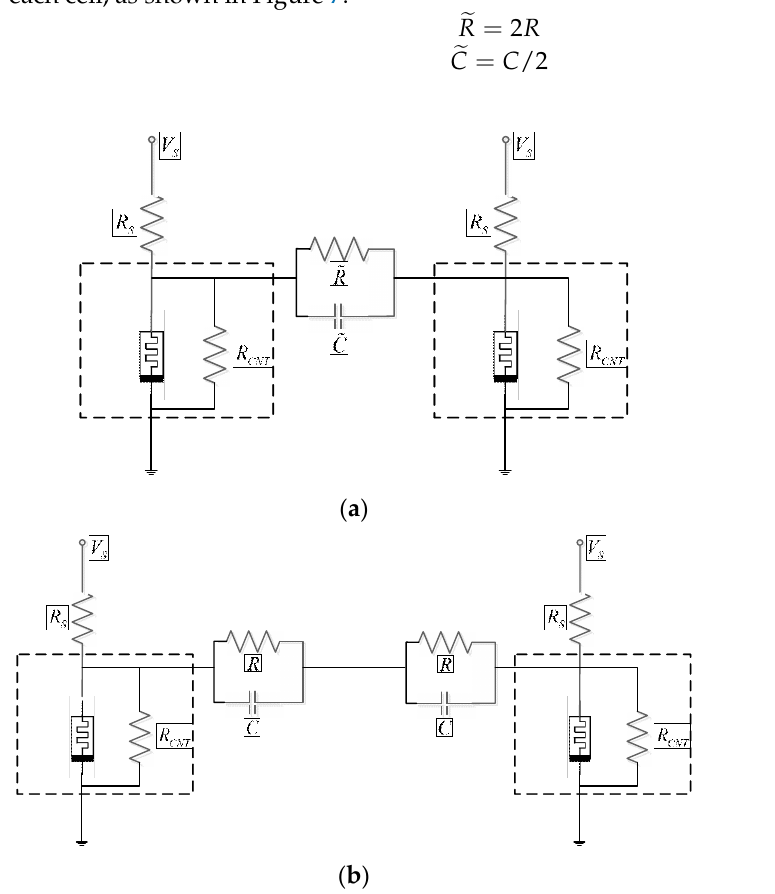
Figure 7. The common resistor and capacitor are equivalent to two parts in the series. ( a ) is the original configuration while ( b ) is its equivalent circuit.